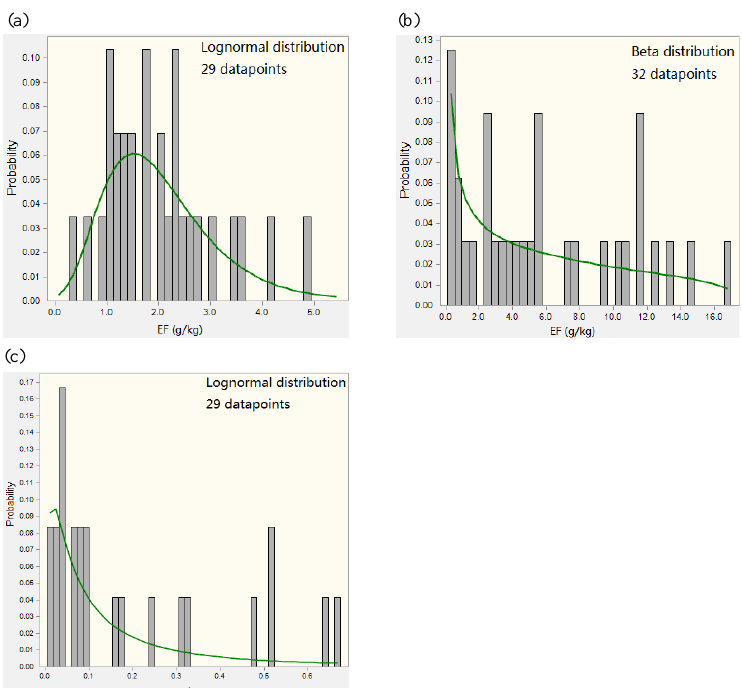
Figure 1. Probability distributions of emission factors for combustion in small stoves: (a) OC from crop waste burning; (b) OC from bituminous chunk-coal burning; and (c) EC from bituminous briquette